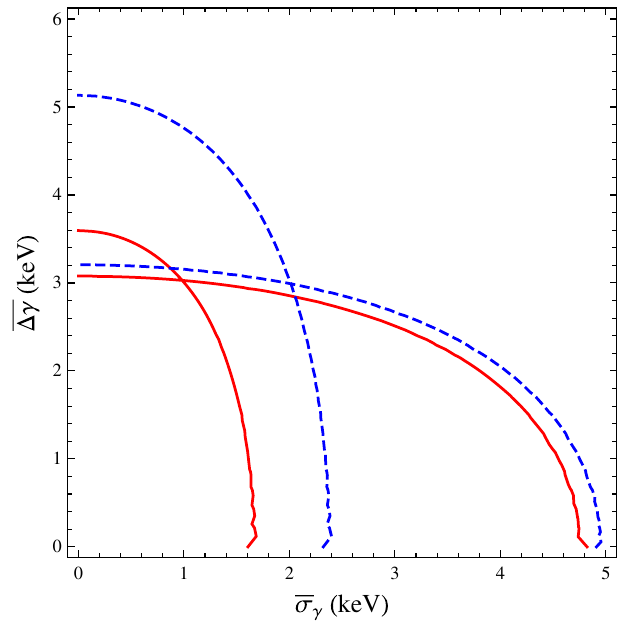
FIG. 3. Calculation results of average local energy spread and average energy modulation amplitude according to Eq. (12) for different conditions as shown in Fig. 1.